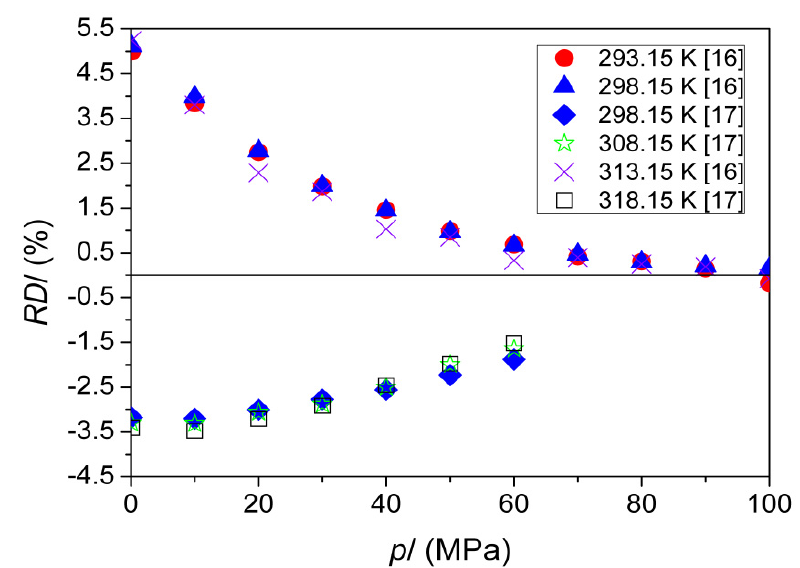
Figure 8. Comparison of the isothermal compressibility of 1-butanol as a function of pressure obtained in this work ( κ T , this work ) with the literature values ( κ T , lit ) [16,17] presented as relative deviations RD s ( RD / % = 100 · ( κ T , this work − κ T , lit ) / κ T , this work ).